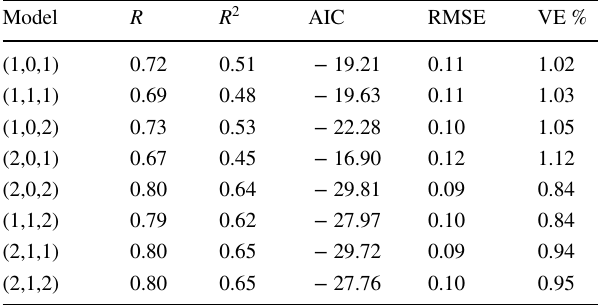
Table 7 The consequences of Mg 2+ group, order (1,1)